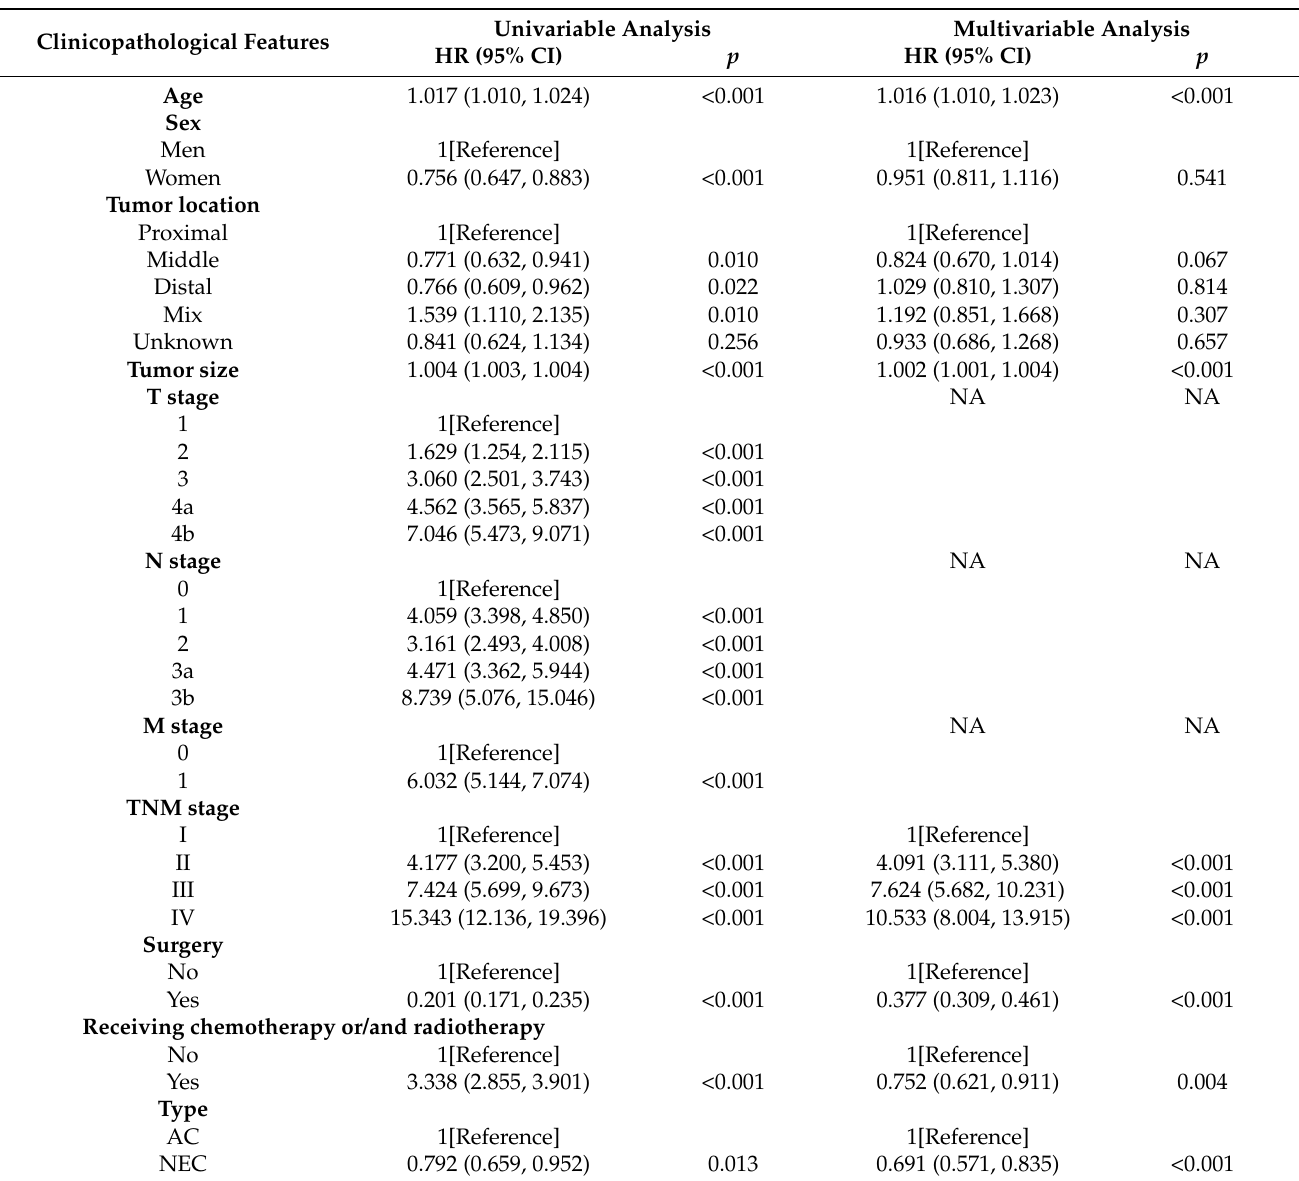
Table 4. Univariable and Multivariable Cox Regression Analyses of Factors Associated with Cancer- specific Survival of White Patients with Gastric Neuroendocrine Carcinoma and Adenocarcinoma in the Matched